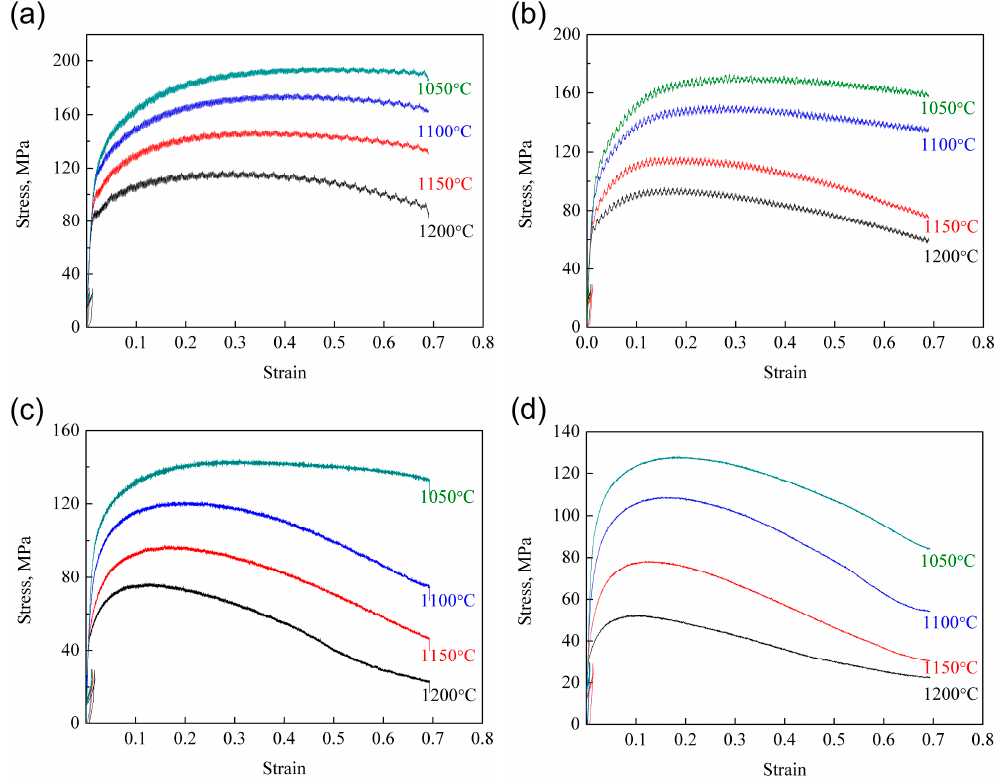
Figure 2. True strain–stress curves of the deformed oxide dispersion strengthened (ODS) samples: ( a ) 1 s − 1 ; ( b ) 0.1 s − 1 ; ( c ) 0.01 s − 1 ; ( d ) 0.001 s − 1 .